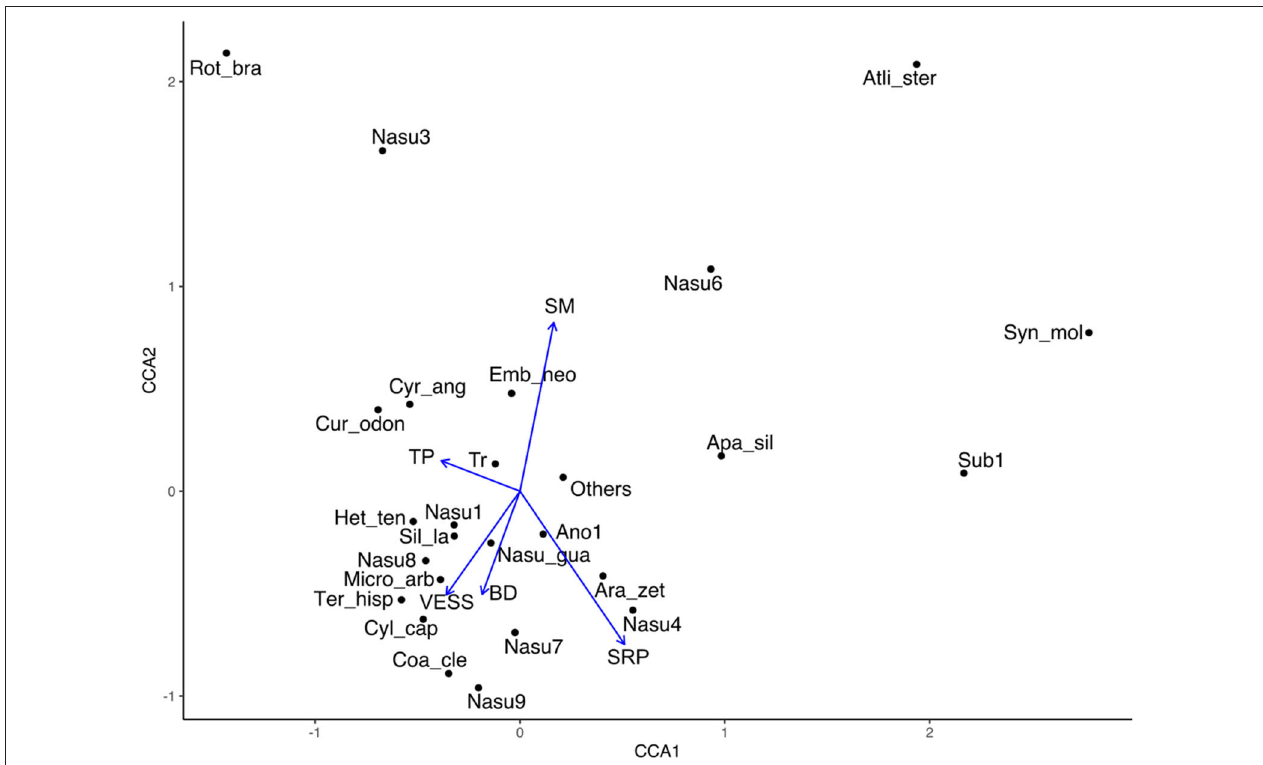
FIGURE 6 | Canonical correspondence analyses (CCA) ordination plot for termite species composition and physical soil variables with a significant effect in Colombian Amazon region. The analysis deals with 24 termite species related to five physical soil variables. SRP, soil resistance to penetration; TP, total porosity; VESS, visual evaluation of soil structure; Ano1, Anoplotermes sp. 1; Apa_sil, Aparatermes silvestrii ; Ara_zet, Araujotermes zeteki ; Atli_ster, Atlantitermes stercophilus ; Coa_cle, Coatitermes clevelandi ; Cur_odon, Curvitermes odontognathus ; Cyl_cap, Cylindrotermes capixaba ; Cyr_ang, Cyrilliotermes angulariceps ; Emb_neo, Embiratermes neotenicus ; Het_ten, Heterotermes tenuis ; Micro_arb, Microcerotermes arboreus ; Nasu_gua, Nasutitermes guayanae ; Nasu1, Nasutitermes sp. 1; Nasu3, Nasutitermes sp. 3; Nasu4, Nasutitermes sp. 4; Nasu6, Nasutitermes sp. 6; Nasu7, Nasutitermes sp. 7; Nasu8, Nasutitermes sp. 8; Nasu9, Nasutitermes sp. 9; Rot_bra, Rotunditermes bragantinus ; Sil_la, Silvestritermes cf. lanei ; Sub1, Subulitermes sp. 1; Syn_mol, Syntermes molestus ; Ter_hisp, Termes hispaniolae ; Tr, total